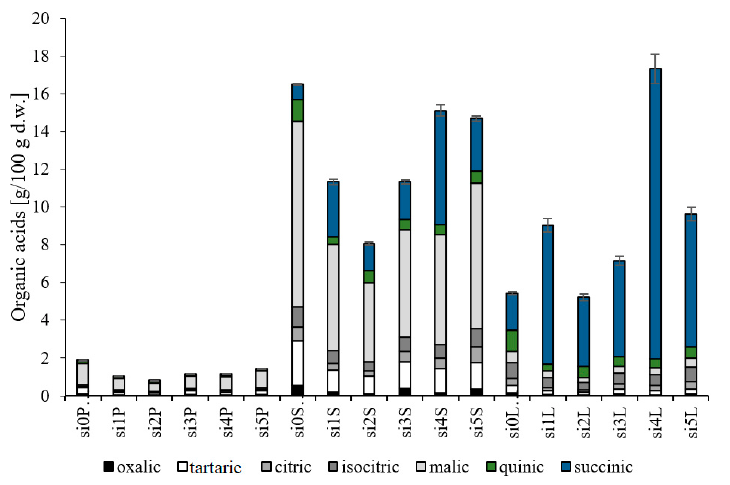
Figure 1. Organic acid profile and amount in fruit skin + pulp, seeds, and leaves of cherry silverberry biotypes. Explanation: si0P-si5P, fruit skin + pulp; si0S-si5S, seeds; and si0L-si5L, leaves.